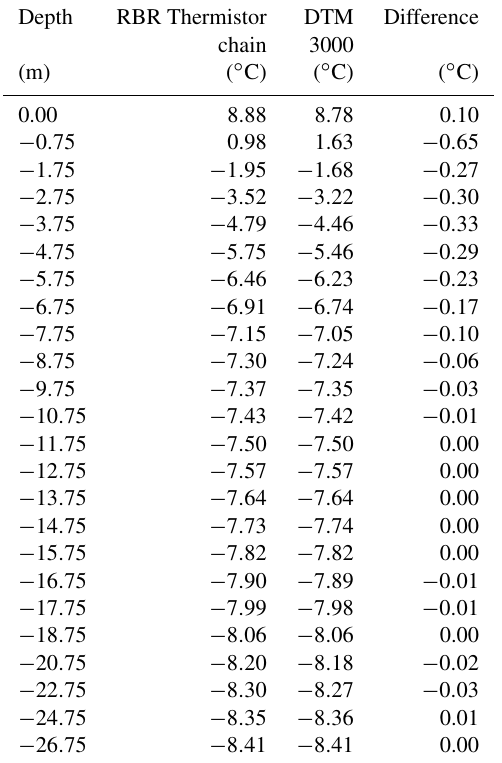
Table E1. In situ calibration of thermometers in the borehole be- tween 9 and 17 August 2014. Comparison measurements were made in the 27m borehole using a certified PT100 thermometer (Service für Messtechnik Geraberg DTM 3000).